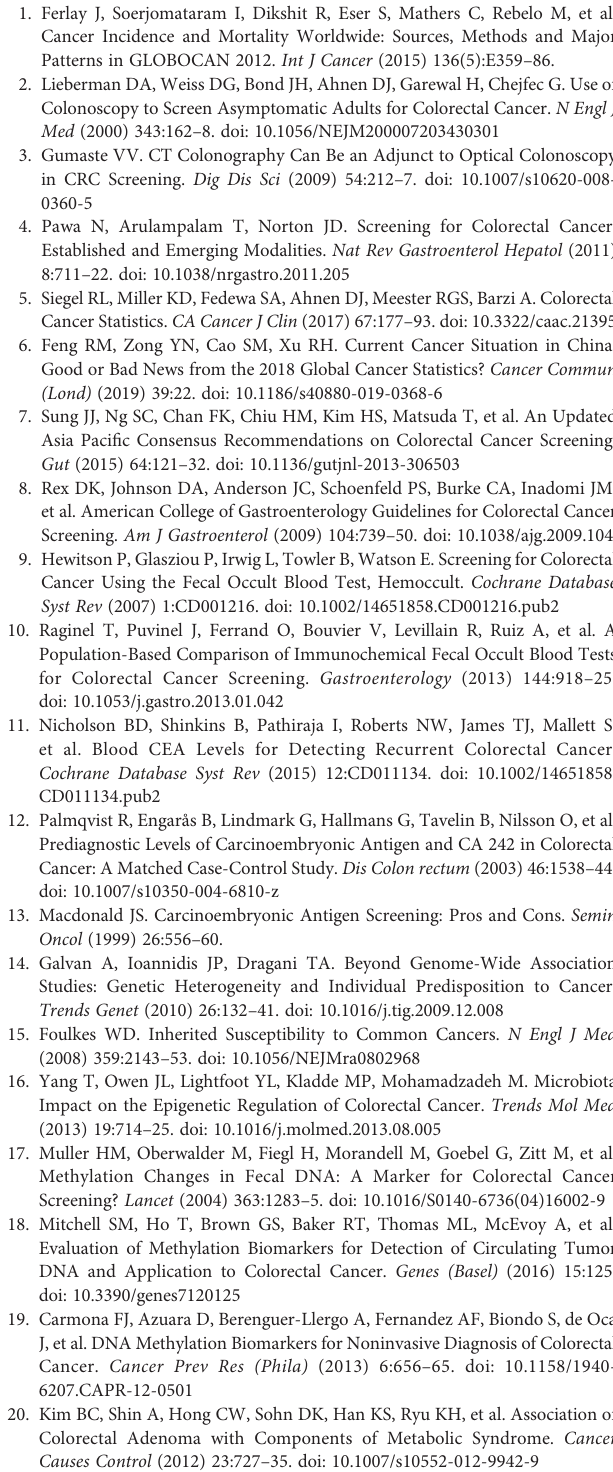
Supplementary Figure 3 | Alpha diversity communities based on observed OTUs by diversity (Simpson, Shannon).